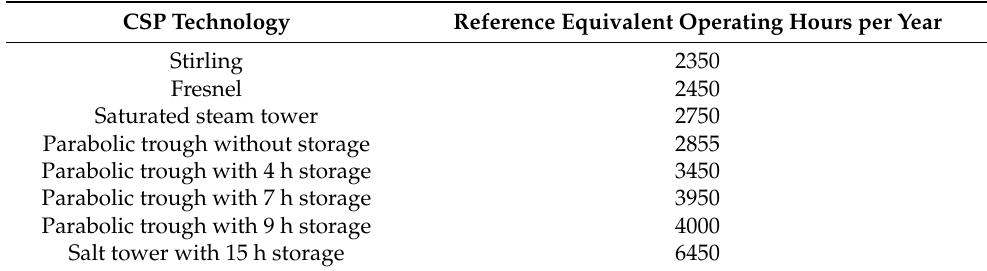
Table 7. Reference equivalent operating hours for CSP power plants set by RD 1614/2010. Source: self-elaboration based on [83].